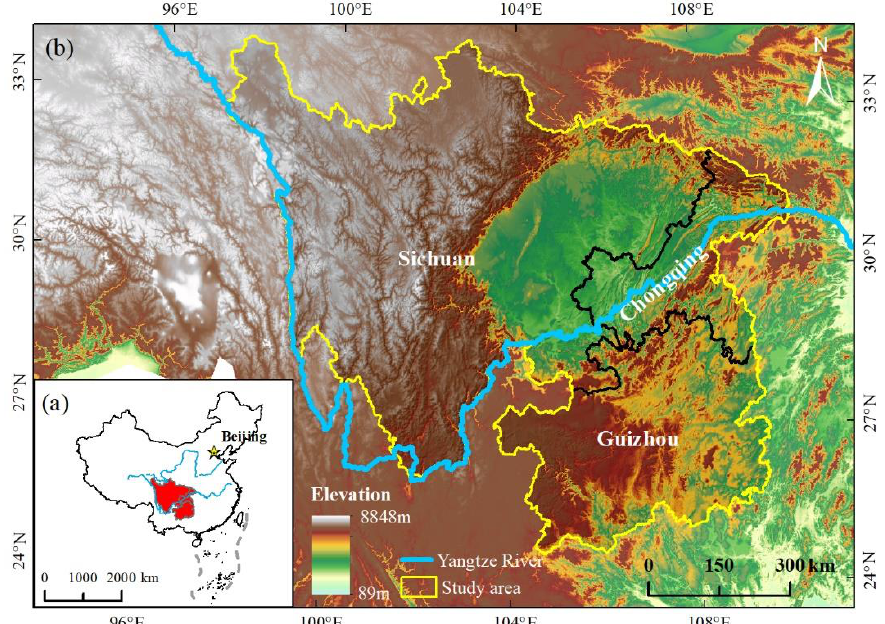
Figure 1. ( a ) Location of the study area in China; ( b ) Elevation distribution of the study